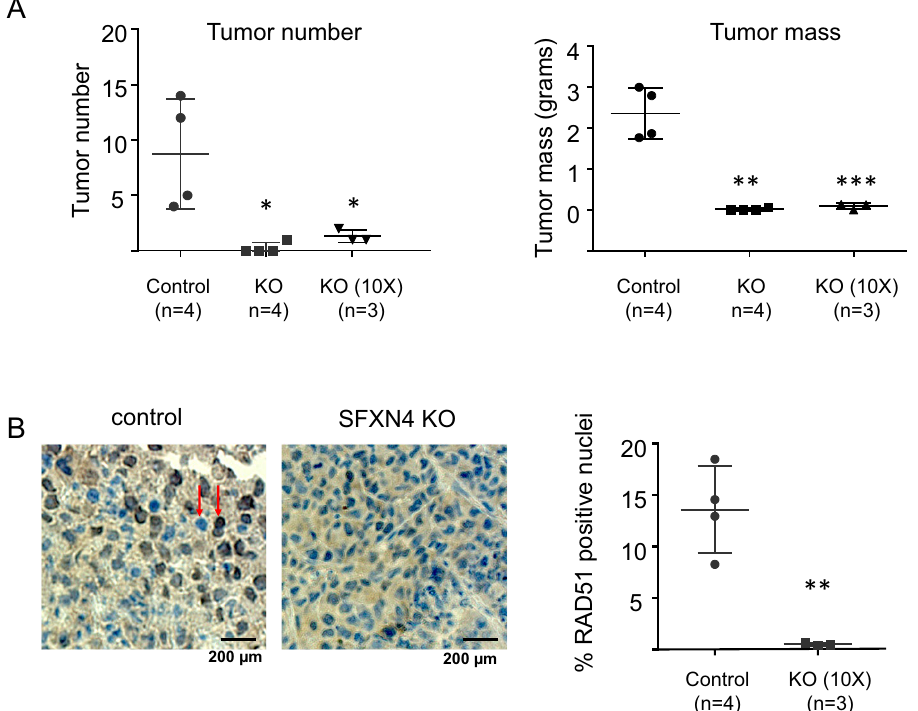
Figure 6. Knockout of SFXN4 reduces tumor number and weight and decreases RAD51 staining in an ovarian cancer metastatic model. ( A ) Control or SFXN4 knockout FT T ovarian cancer stem cells were injected into the mouse peritoneal cavity and tumor number and mass assessed 23 days later. Control cells were injected at 2 × 10 5 cells/mouse (n = 4) and SFXN4 knockout cells were injected at either the same dose (2 × 10 5 cells/mouse, n = 4) or tenfold higher (2 × 10 6 cells/mouse—10 ×; n = 3). ( B ) Tumors were excised from control mice or SFXN4 KO mice and stained for RAD51. Left: representative images with examples of positive and negative nuclear staining indicated (arrows), scale bar is 200 µm; right: average percent RAD51 positive nuclei per tumor *p < 0.05; **p < 0.005; ***p <